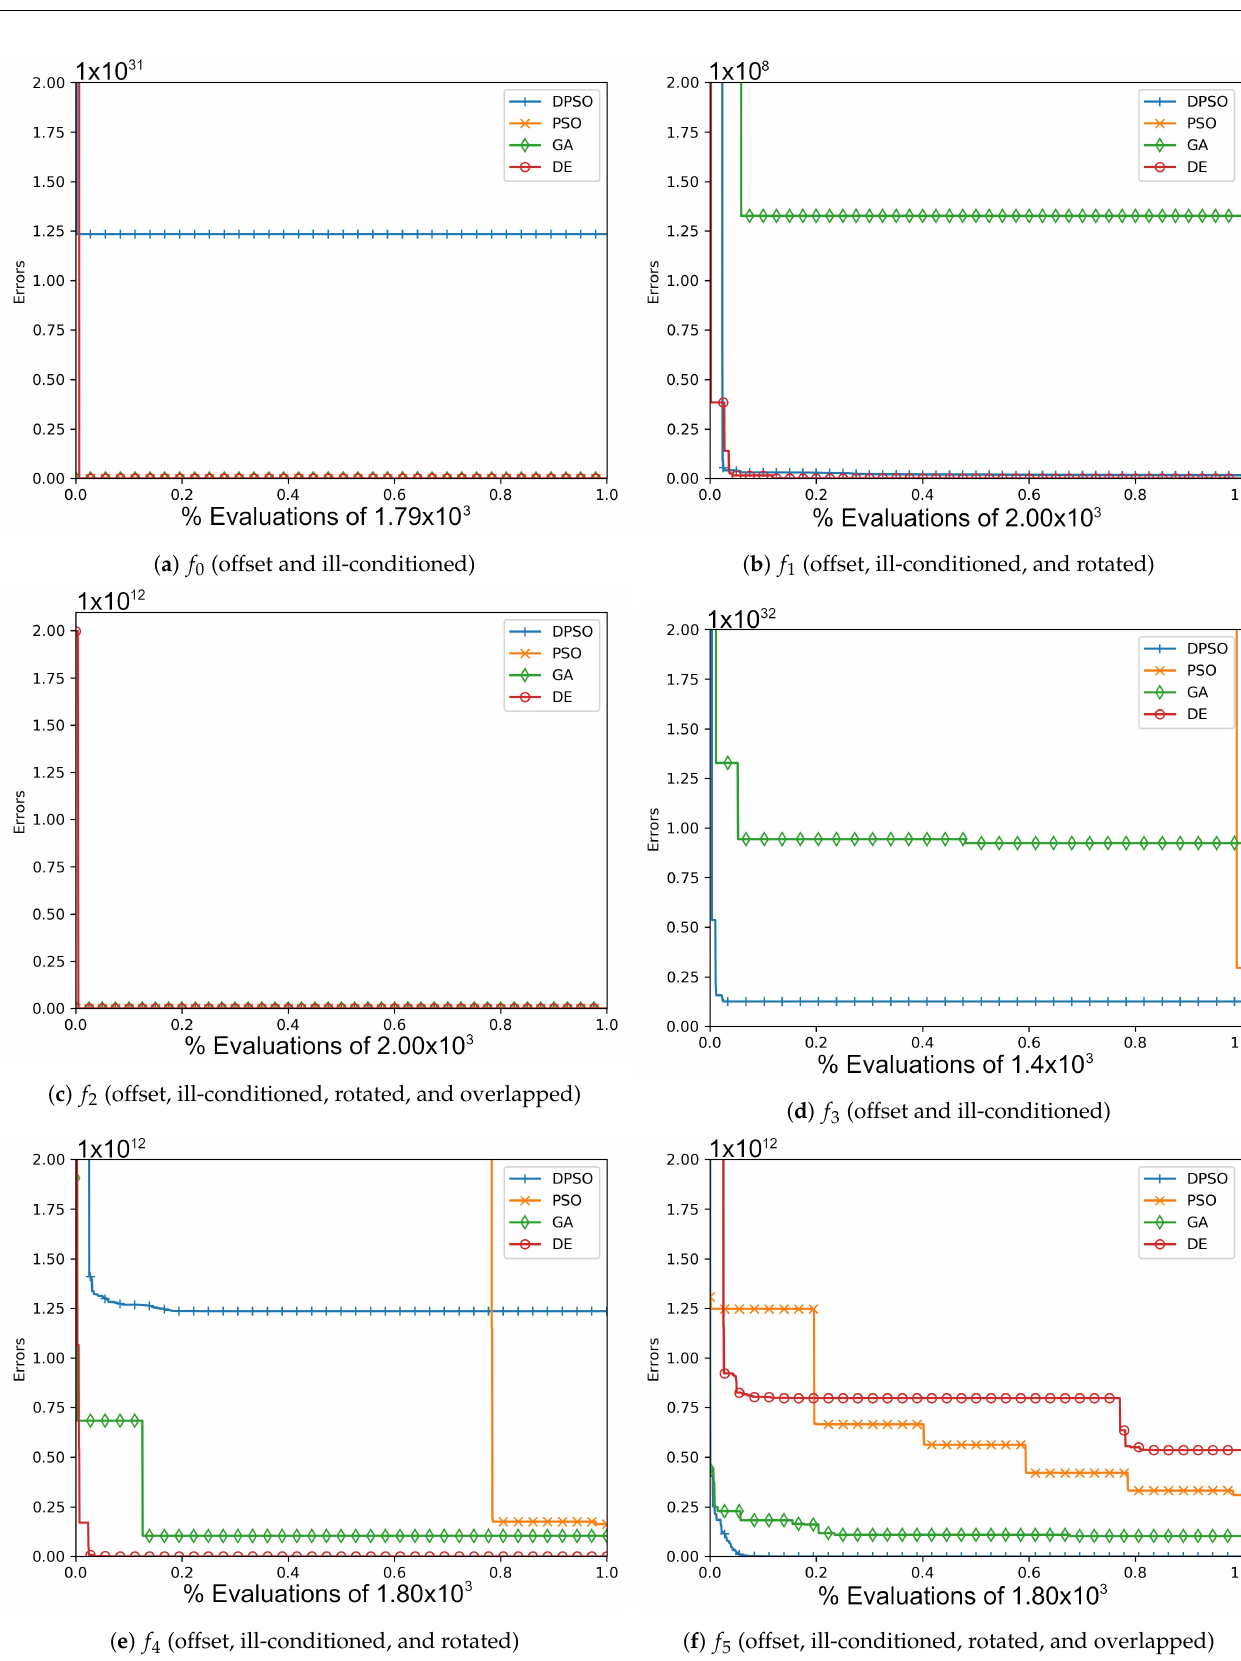
Figure A1. The average In-Sample ( f 0 , f 1 , f 2 ) and Elliptical ( f 3 , f 4 , f 5 ) global best results over time for 7